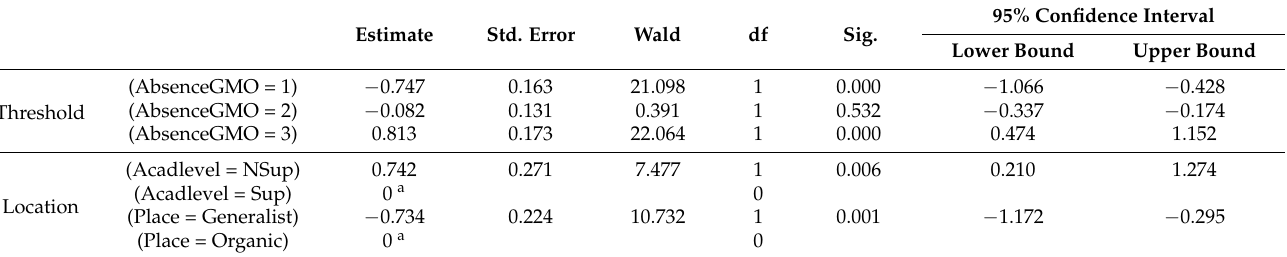
Table 9. Parameter